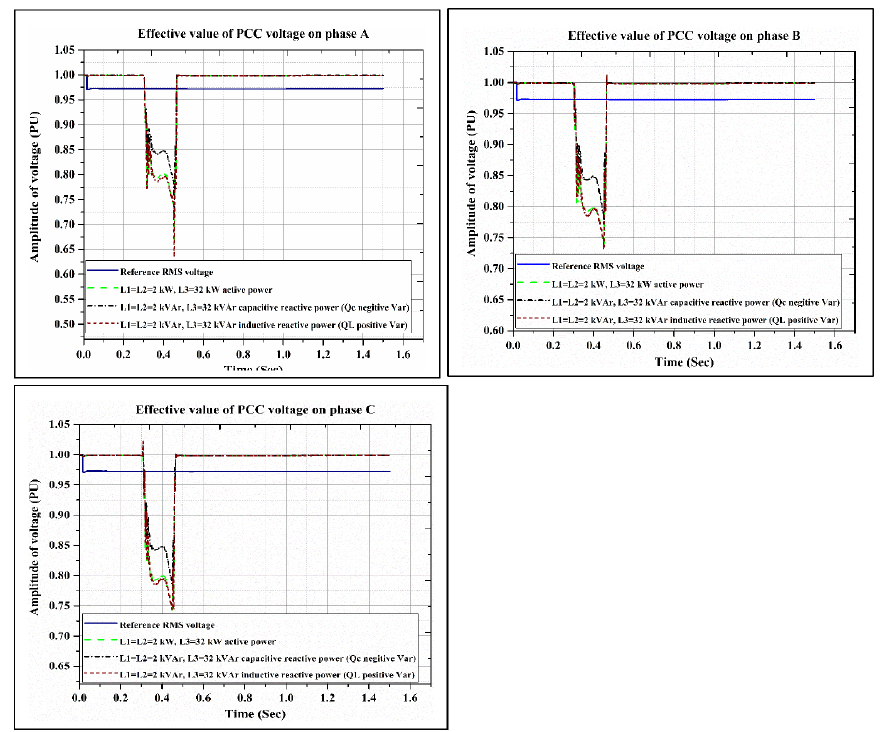
Figure 12. The effective value of PCC voltage when local loads are smaller than local generation.